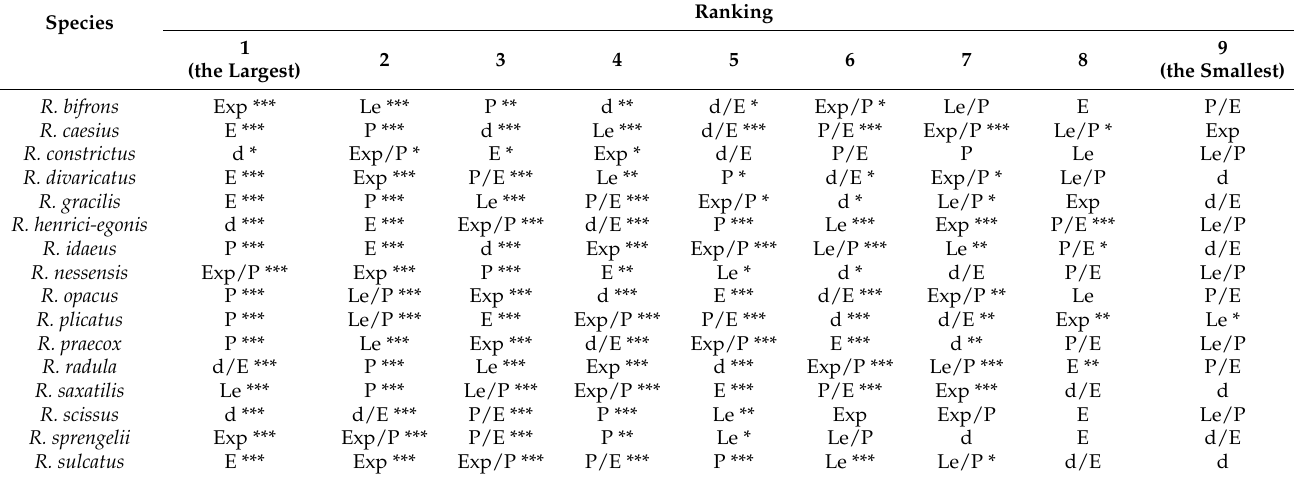
Table 8. The ranking of features determining intraspecific variability.